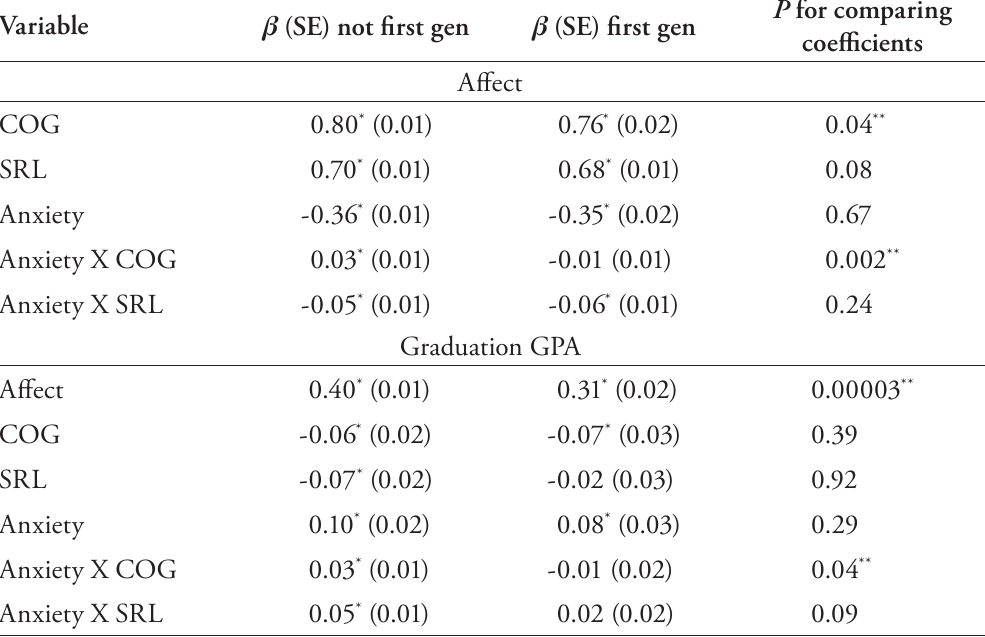
Table 3. Standardized Model Coefficients by First- Generation Status, and Comparison across